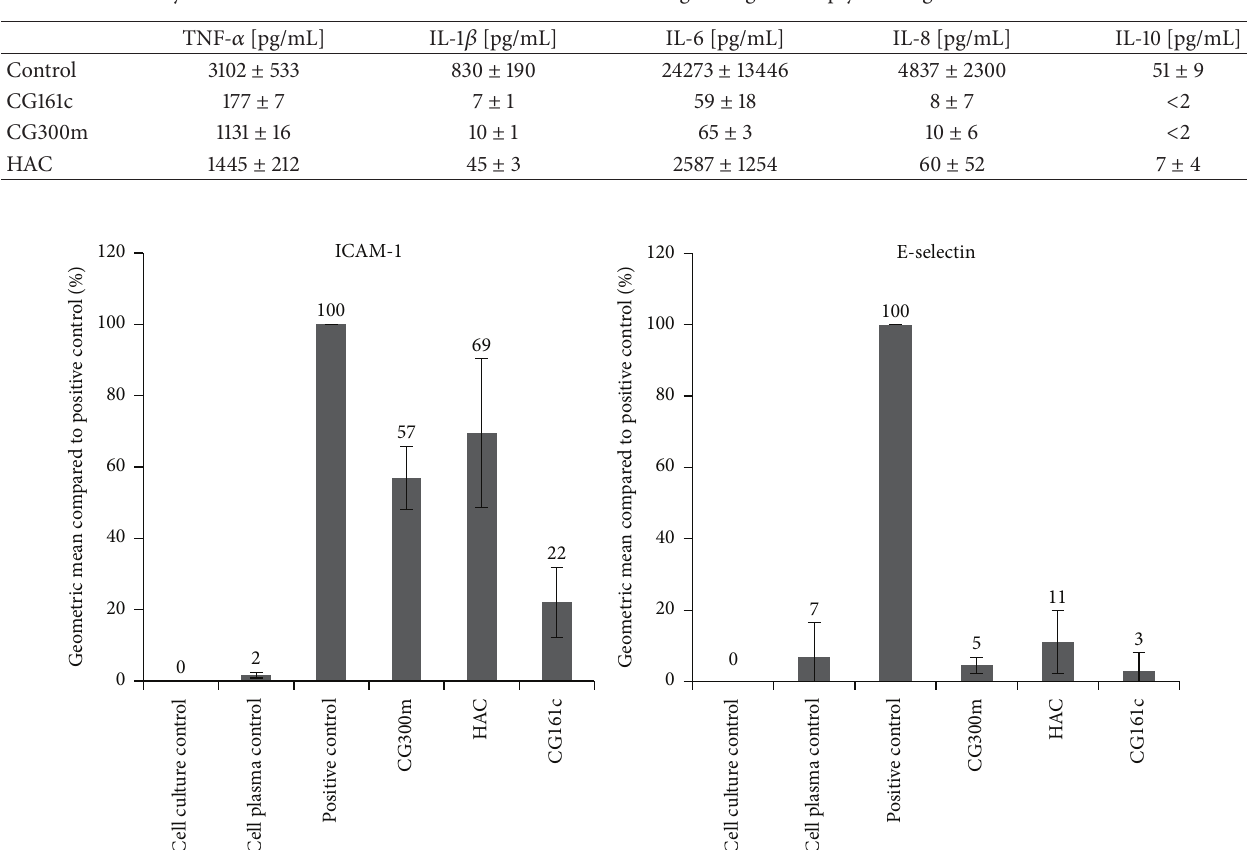
Table 3: Cytokine levels of treated plasma. Mean cytokine concentration ± SD ( 𝑛 = 3 ) in plasma after 6 hours of treatment with different adsorbents in the dynamic model. Plasma from LPS treated blood circulating through an empty cartridge acted as control.